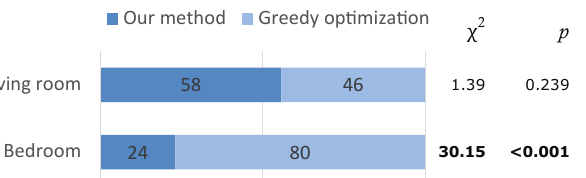
Figure 8. Frequencies of user preferences in our study. All displayed conditions show the pref- erences among answers of 52 participants (104 answers per room). The results of the Chi-square analysis are indicated on the right side. Values in boldface indicate significant difference (level of significance = 0.05).